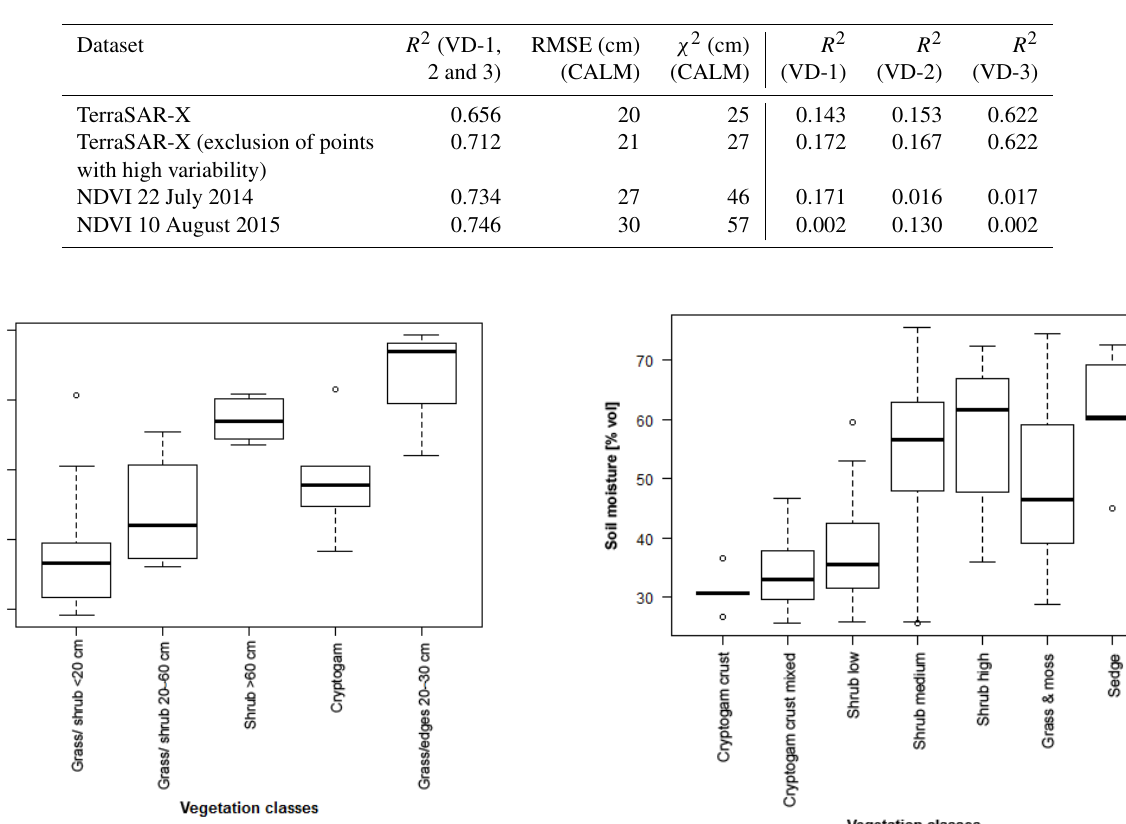
Table 2. R 2 between X-band backscatter and NDVI (22 July 2014 and 10 August 2015) and ALT. R 2 has been calculated for all calibration sites combined (VD-1,2 and 3) and separately (ALT range for VD-1: 56–108cm; VD-2: 45–102cm; VD-3: 90–140cm). RMSE values represent the modeled ALT (linear regression of sites VD-1, VD-2 and VD-3) versus the measured ALT at the CALM site. χ 2 statistics compare the modeled and measured ALT at the CALM site under consideration of observational uncertainties.